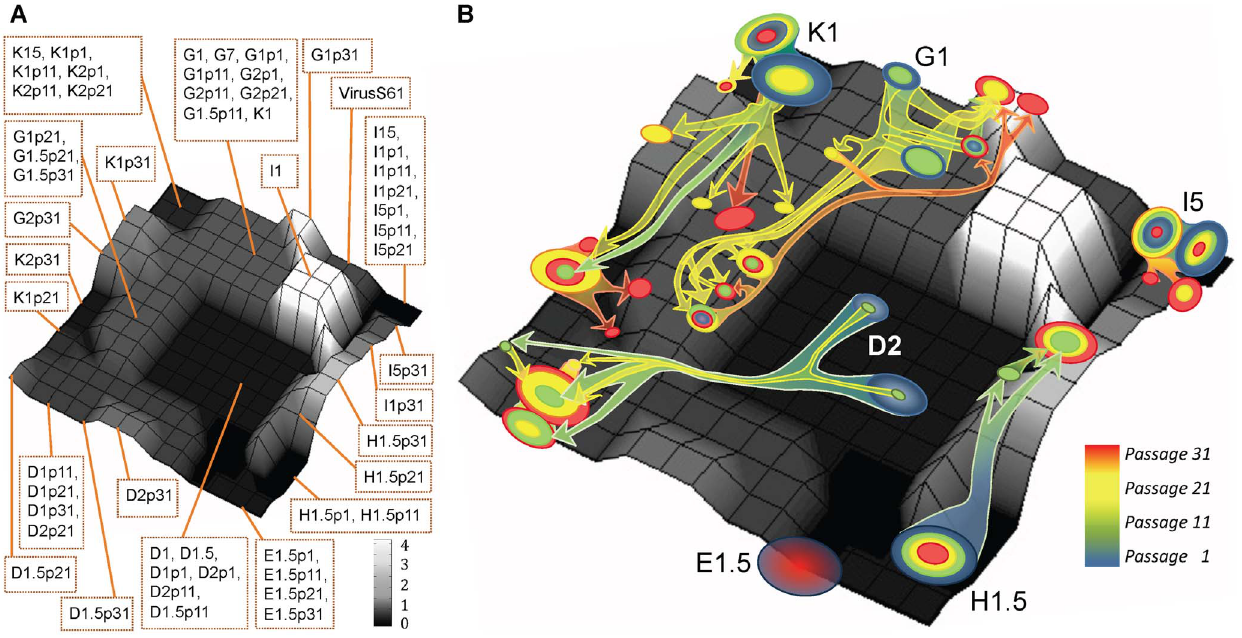
Figure 4. Representation of the fitness landscape from viral consensus sequences in the V1–V2 region in env gene and of the evolutionary trajectories of quasispecies variants. The landscape was created by SOM (15 6 15 neurons) with the 55 consensus sequences in the V1–V2 region in env gene from the global sequences, labelled as in Figure 3 (with an L =1 factor) and drawn using the same grey scale as in Figure 3. A) Fitness landscape map showing the neuron that maps each viral consensus sequence. B) Representation of some of the 911 sequences from the viral quasispecies dataset, with unknown fitness values, projected on this fitness landscape map. The quasispecies variants from each virus are displayed as a circle over the neuron that maps them, and the diameter of the circle symbolizes the proportion of variants identified in passage 1 (in blue), passage 11 (in green), passage 21 (yellow) and passage 31 (red). The quantification of the quasispecies variants in each neuron is summarized in Table S4 in File S1. Colour arrows joining the circles show the estimated evolutionary trajectories of the viral clones during the recovery passages.